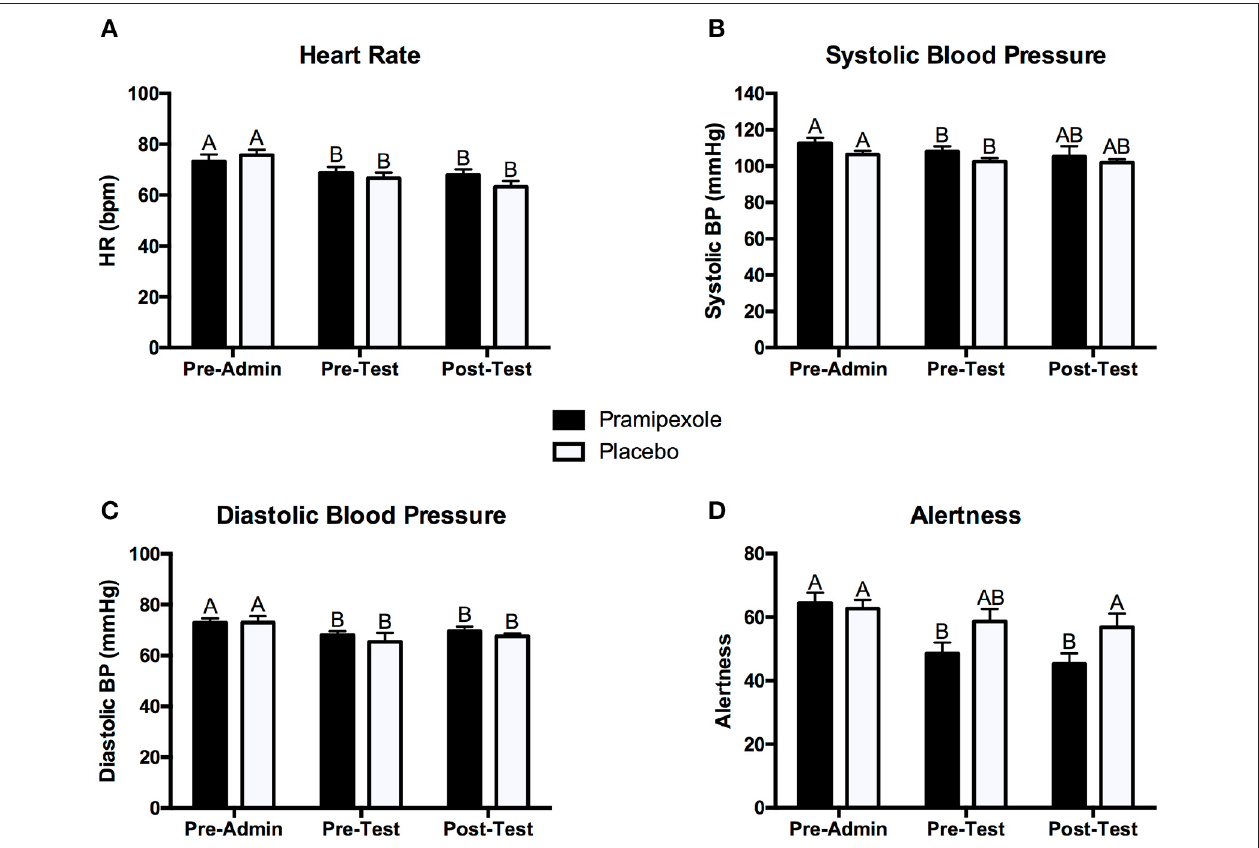
FIGURE 2 | Mean (A) heart rate, (B) systolic blood pressure, (C) diastolic blood pressure, and (D) alertness scores for the pramipexole and placebo groups at pre-administration, pre-test, and post-test. Error bars represent standard error of the mean. Means with different letters are significantly different; p <